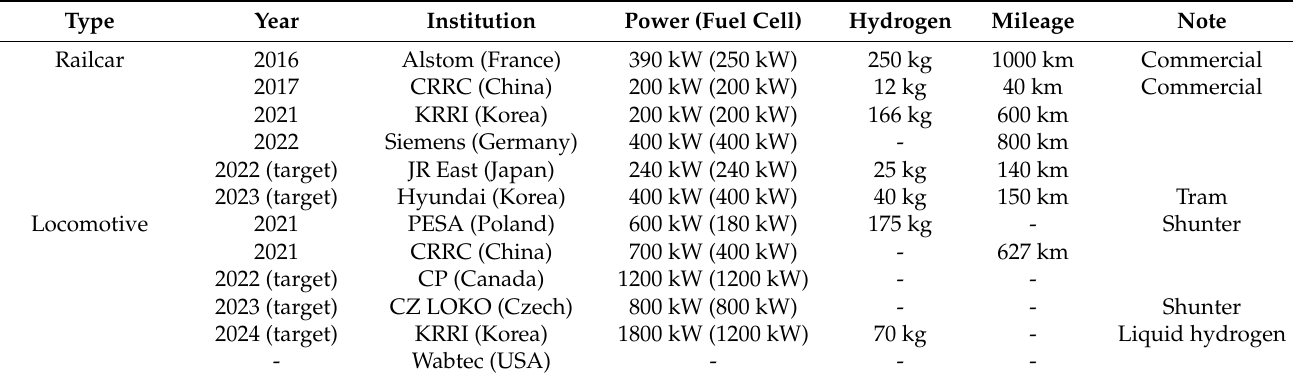
Table 2. Recent cases of hydrogen